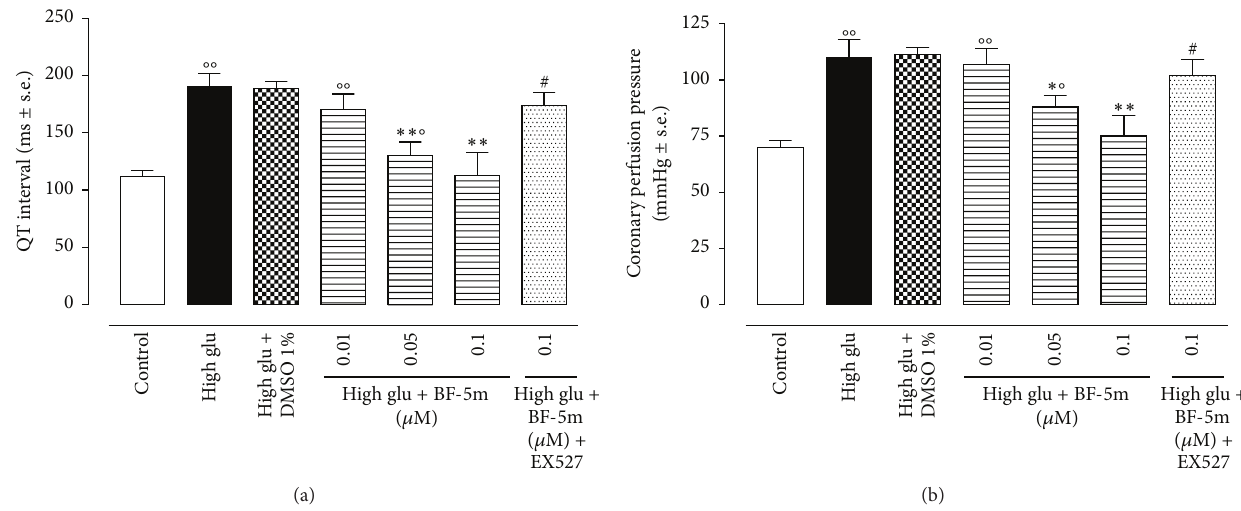
Figure 2: (a) Cardiac QT interval in hearts of Sprague-Dawley rats perfused for two hours in a Langendorff apparatus with Krebs solution containing D-glucose 11.1mM (control); glucose 11.1mM + DMSO 1% (vehicle); glucose 33.3 mM (high glu); high glu + BF-5m (0.01, 0.05, and 0.1 𝜇 M); high glu + BF-5m (0.1 𝜇 M) + EX527 (10mg/kg/day i.p.). (b) Coronary perfusion pressure (CPP) recorded on a Power Lab system following exposure of perfused hearts to the same treatments as in panel (a). Values are expressed as the mean of 10 observations ± s.e.m. Significant differences versus control are reported as ∘ 𝑃 < 0.05 and ∘∘ 𝑃 < 0.01 ; significant differences versus high glu are reported as ∗ 𝑃 < 0.05 and ∗∗ 𝑃 < 0.01 ; significant differences versus high glu + BF-5m 0.1 𝜇 M are reported as # 𝑃 < 0.01